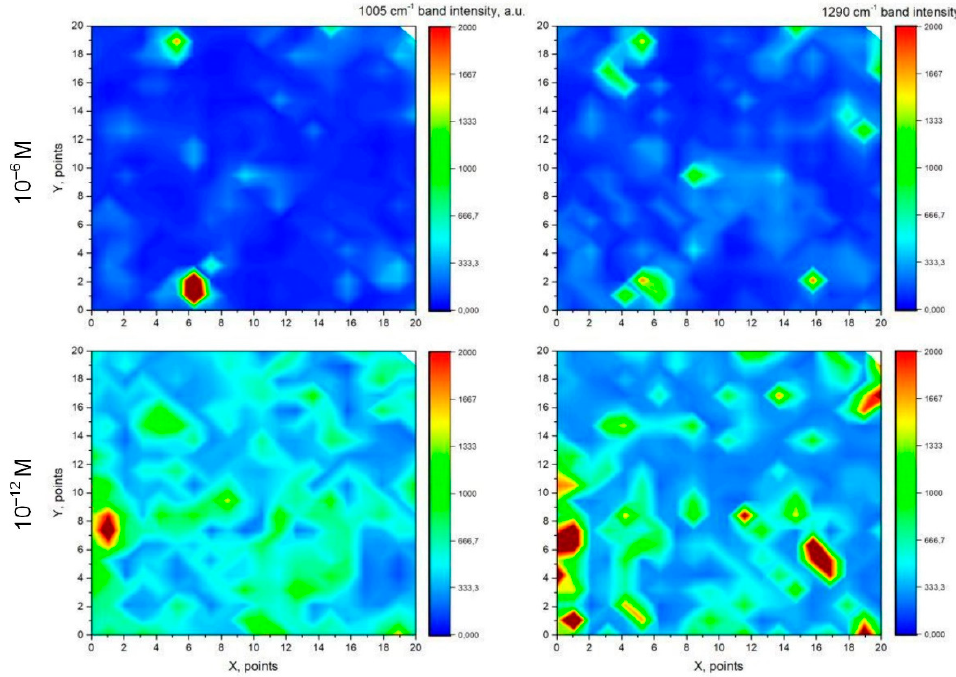
Figure 9. Distribution of the SERS-signal intensity at the 1005 and 1290 cm − 1 bands in the SERS-spectra of the lactoferrin molecules adsorbed on the silvered por -Si from the solutions at 10 − 6 and 10 − 12 M. The size of each map is 10 × 10 μ m.